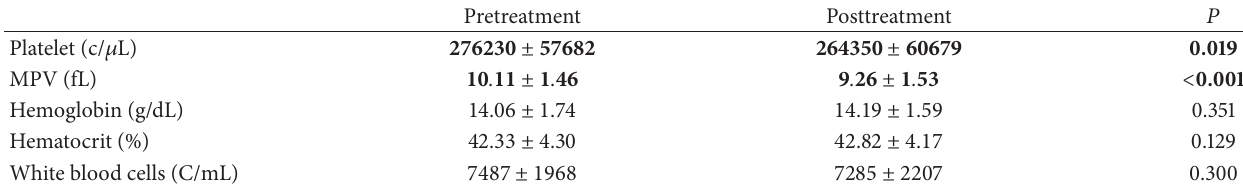
Table 1: PLT, MPV, Hb, Htc, and WBC levels prior to and following the